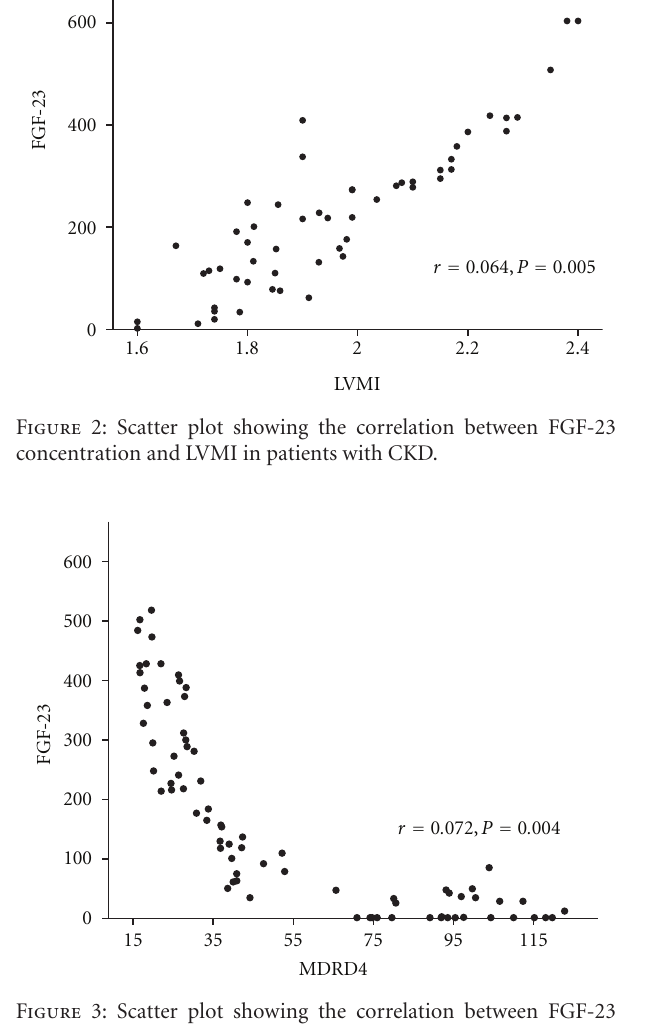
Figure 3: Scatter plot showing the correlation between FGF-23 concentration and renal function by the MDRD4 equation in all patients.